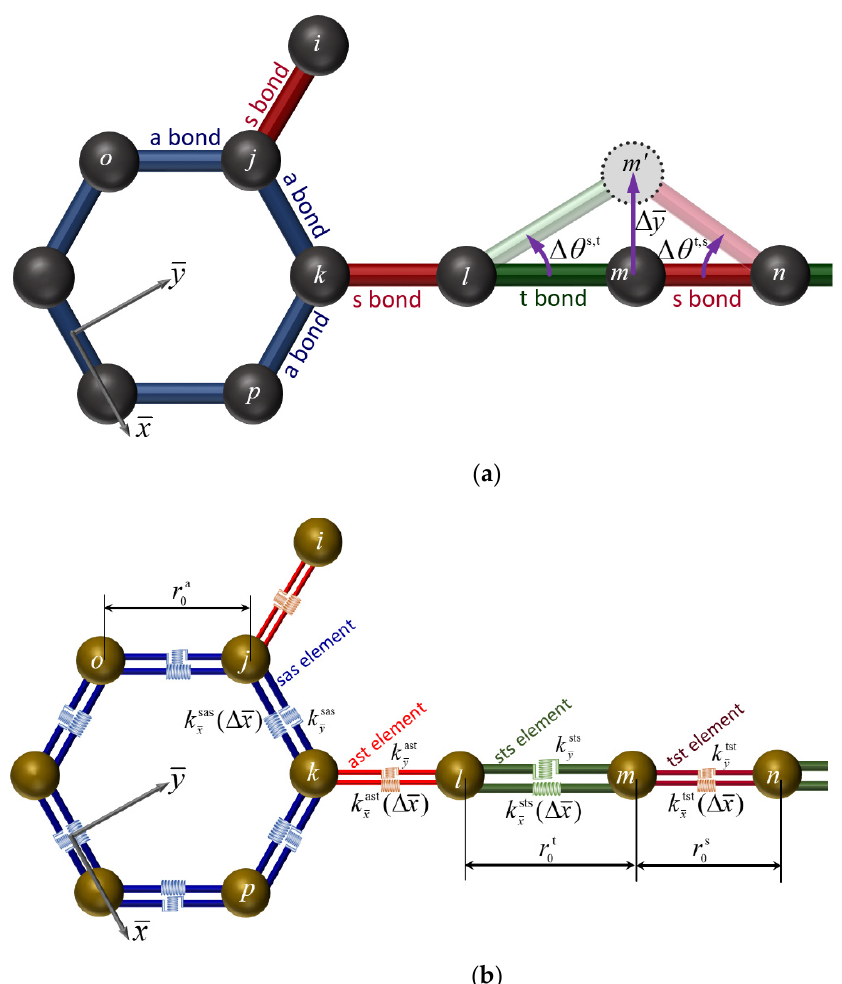
Figure 2. Indicative nanostructure of graphyne: ( a ) configuration of bonds and ( b ) spring-like finite element representation.